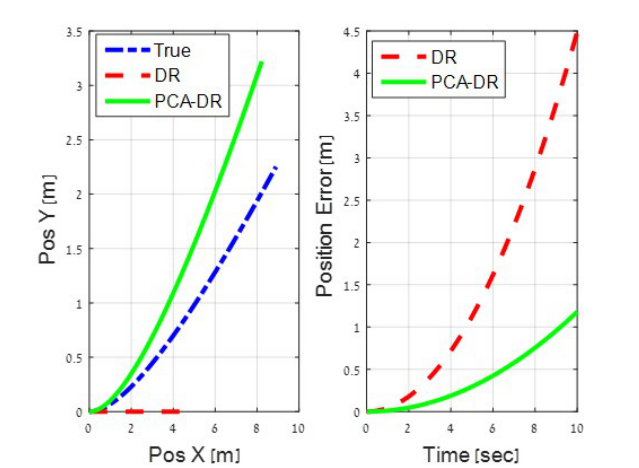
Figure 10. Comparison between traditional DR and PCA-DR. Left panel: actual position of the two approaches relative to the true position. Right panel: position error of the two